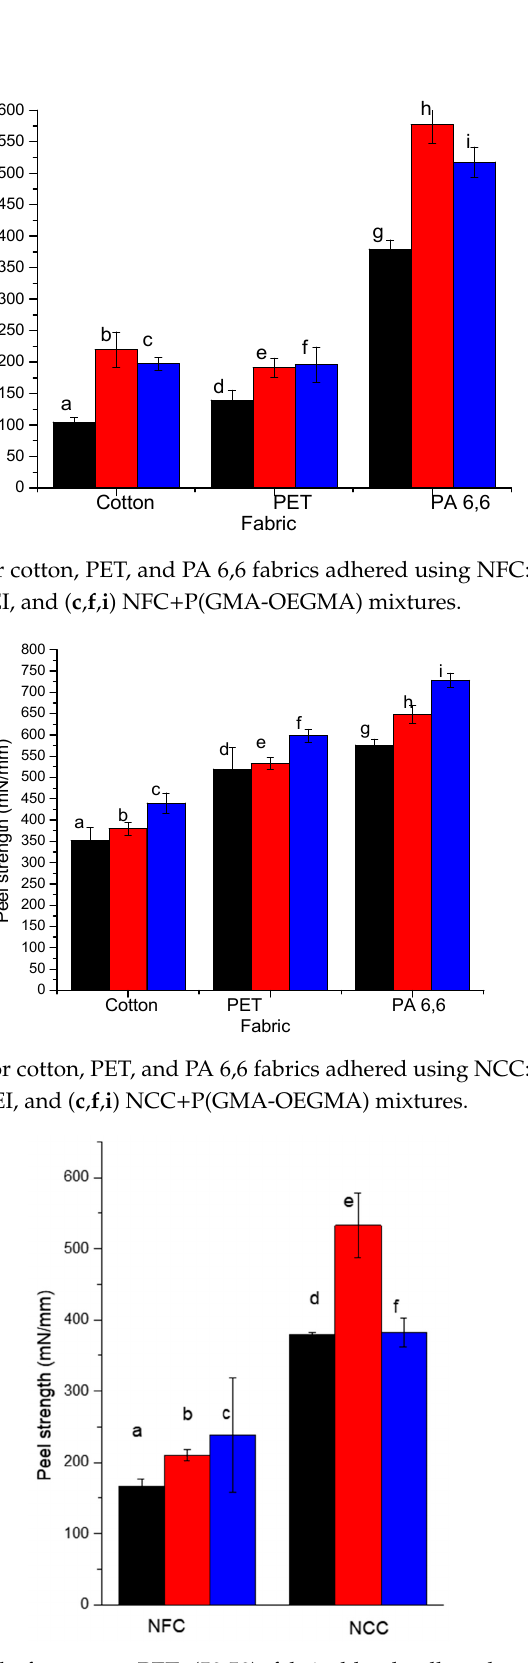
Figure 11. Peel strength for cotton-PET (50:50) fabric blend adhered with ( a , d , c ) NFC and ( d – f ) NFC: ( a , d ) with no additives, ( b ) NFC + PEI, ( e ) NCC + PEI, ( c ) NFC + P(GMA-OEGMA), and ( f ) NCC + P(GMA-OEGMA) mixtures.